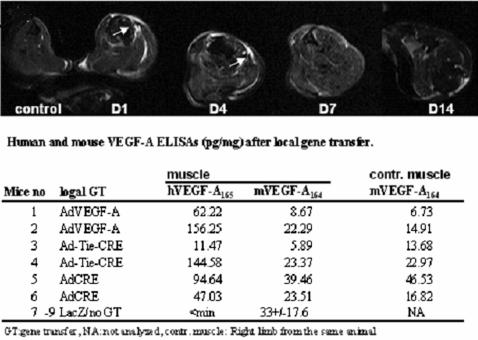
Edema after AdCre mediated local gene transfer detected by MRI and results from human and mouse ELISA analyses after local GT. Discrete edema (white areas pointed with arrows) is clearly visible between day 1 and day 7 under the skin in T2 weighted MRI images in the transduced leg muscles, their fascias, and in the fat tissue within the transduced muscles.ELISA assays were done as described in the Methods.